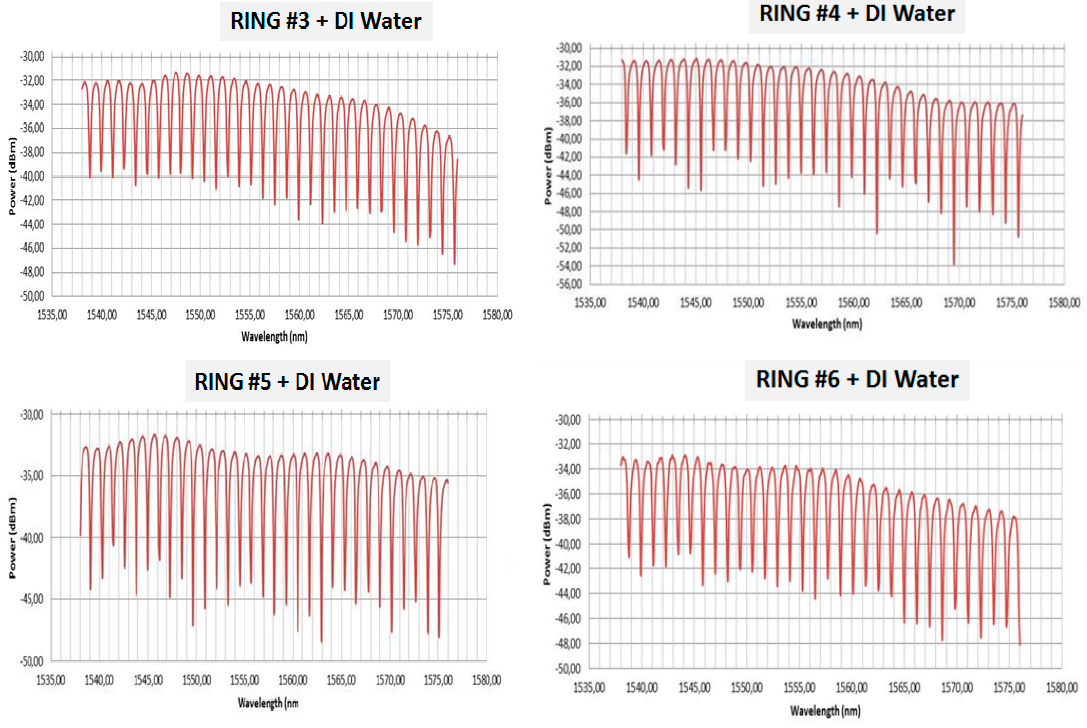
Figure 5. Optical response of several ring resonators of a fabricated biosensor PIC.